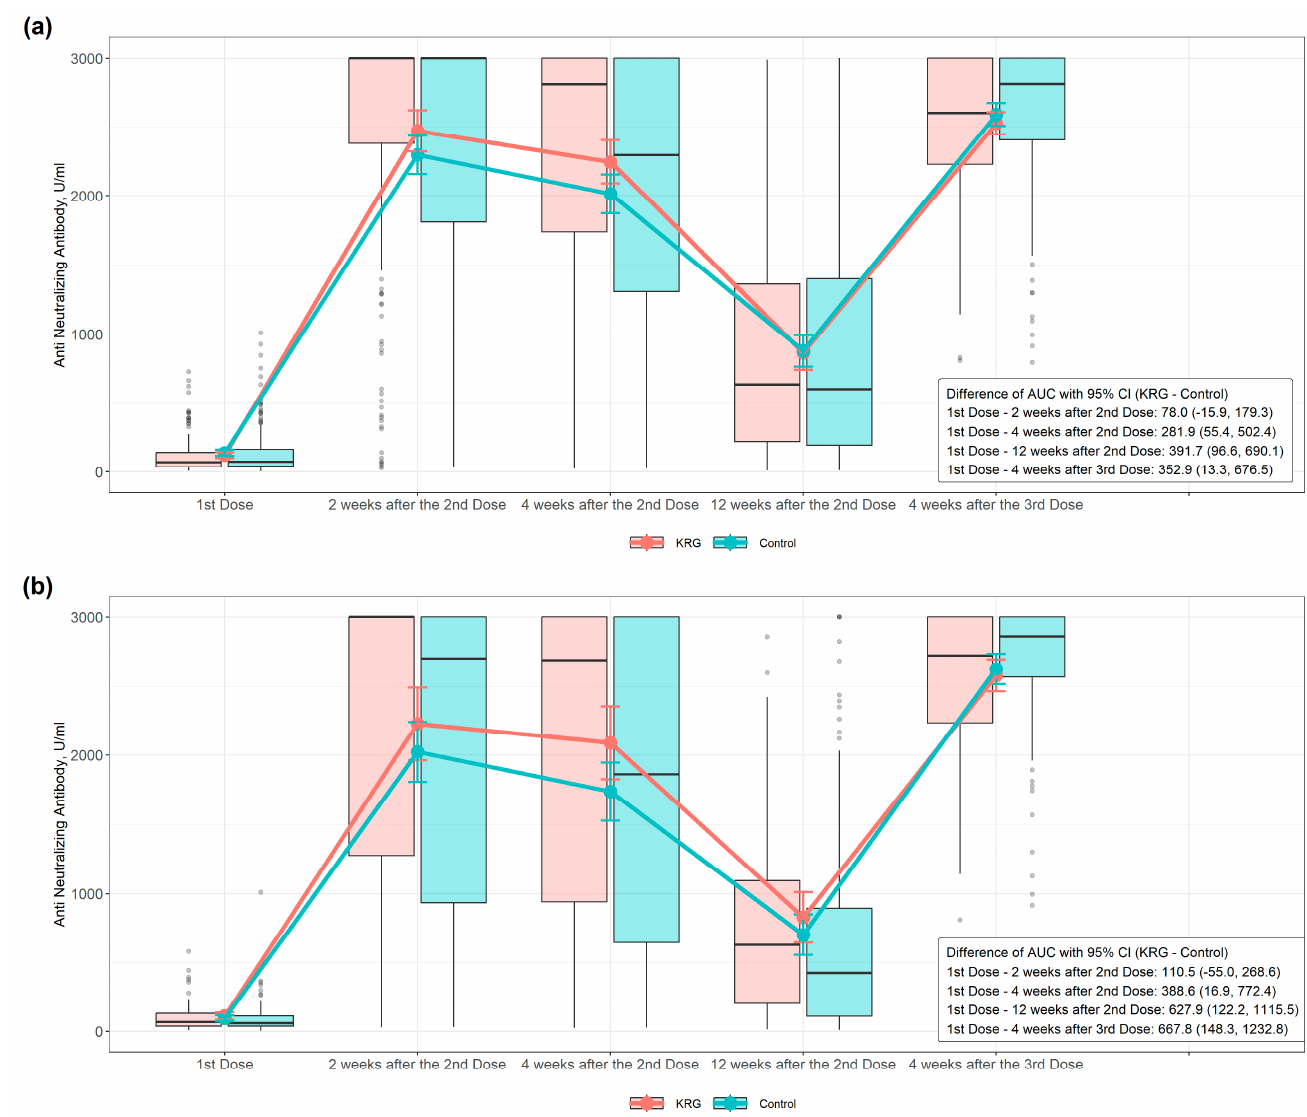
Figure 2. Antibody responses to two vaccine doses in two groups: ( a ) Anti-Neutralizing-Ab in subjects and ( b ) Anti-Neutralizing-Ab in subjects over 50 years old. Blood samples were collected from individuals 4 weeks after first dose; 2 weeks, 4 weeks, and 12 weeks after second dose; and 4 weeks after the third dose. Neutralizing antibodies were screened and differentiated using the Neutralization Antibody Detection kit as described in the Materials and Methods. The x-axis shows time points just before the second dose of vaccine administration; 2, 4, and 12 weeks after the second dose; and 4 weeks after the third dose. Meanwhile, the y-axis shows antibody concentrations as mean ± SD. The area under the curve (AUC) was calculated using a linear trapezoidal